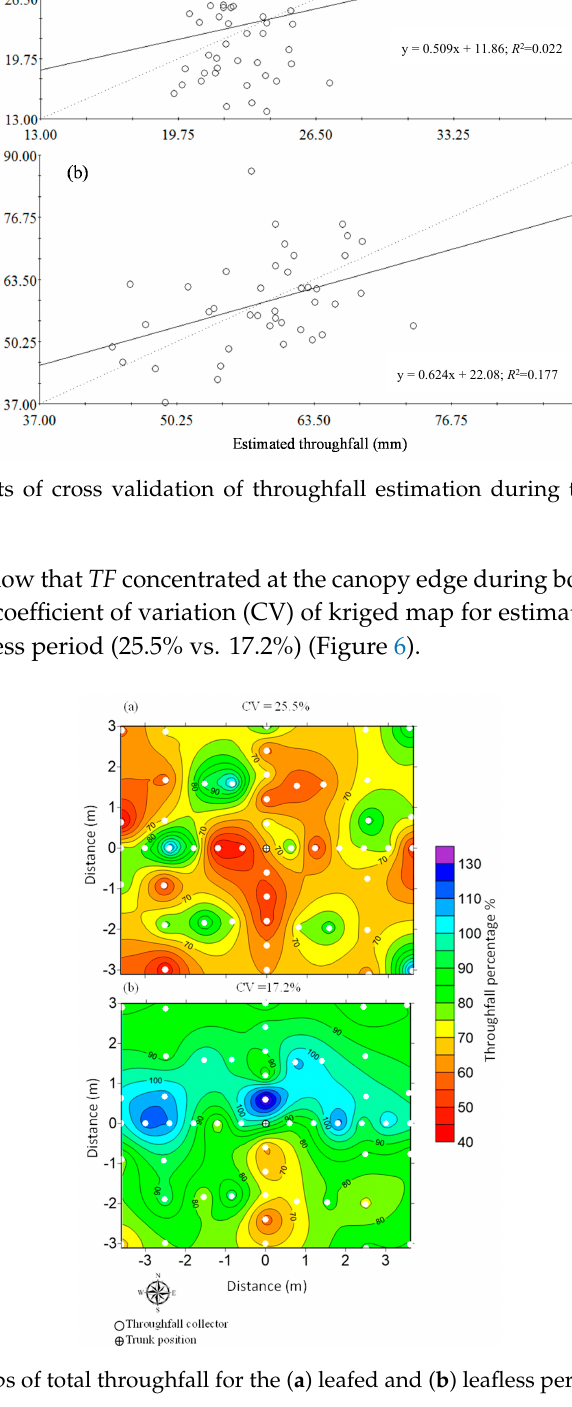
Figure 6. Kriged maps of total throughfall for the ( a ) leafed and ( b ) leafless periods. CV = coefficient of variation. 3.3. Temporal Stability of Spatial Throughfall of Comparing the two phenoseasons, there was no significant correlation between cumulative TF of the leafed and leafless periods (r s = 0.157, p = 0.275) (Table 1). After dividing the rainfall events into three rainfall classes, at the temporal scale of cumulative TF of events, the summed TF amounts per rainfall class within the leafed period were significantly correlated with each other (Table 1). At the rain event level, a significant ( p < 0.05, n = 50) and positive Spearman correlation coefficient between event TF was found for 76.4% of the pairs of events ( n = 55) in the leafed periods. Of three pairs of events in the leafless period, only one pair (r s = 0.347, p < 0.05) were positively correlated to each other.